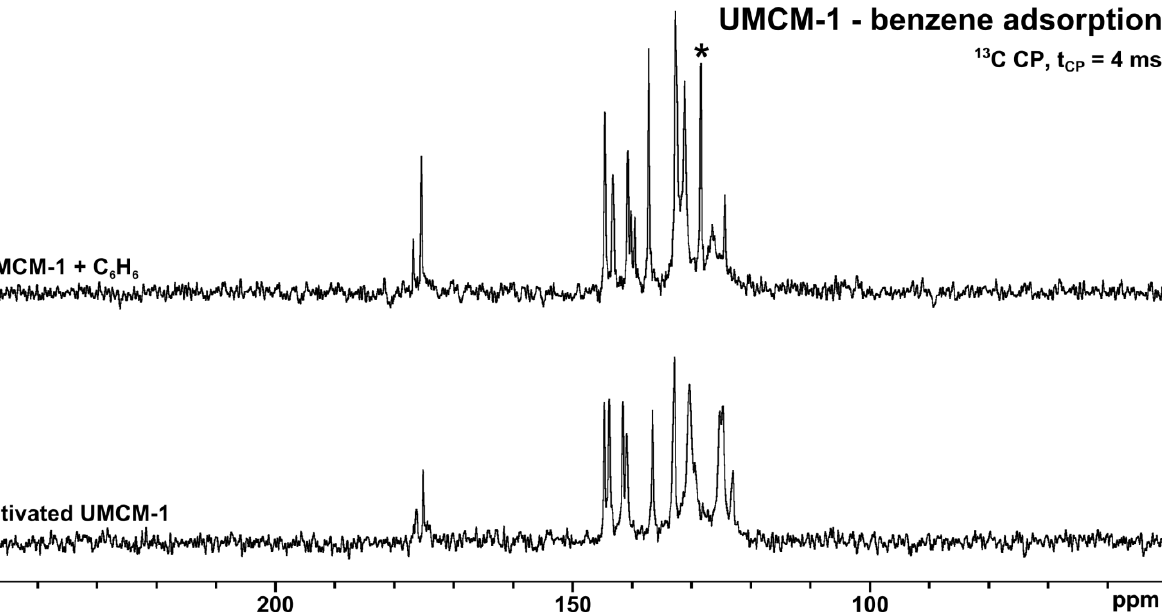
H is denoted by an 6 6